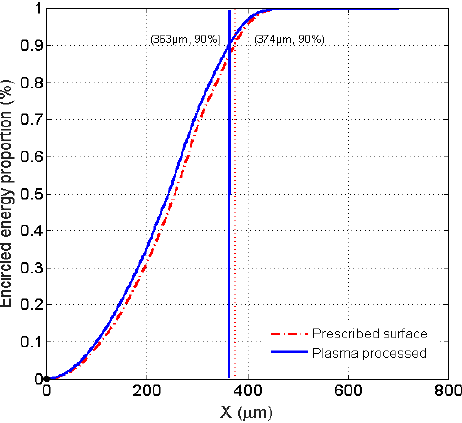
Figure 10. The relationship between the energy proportion and the diameter from the centroid.